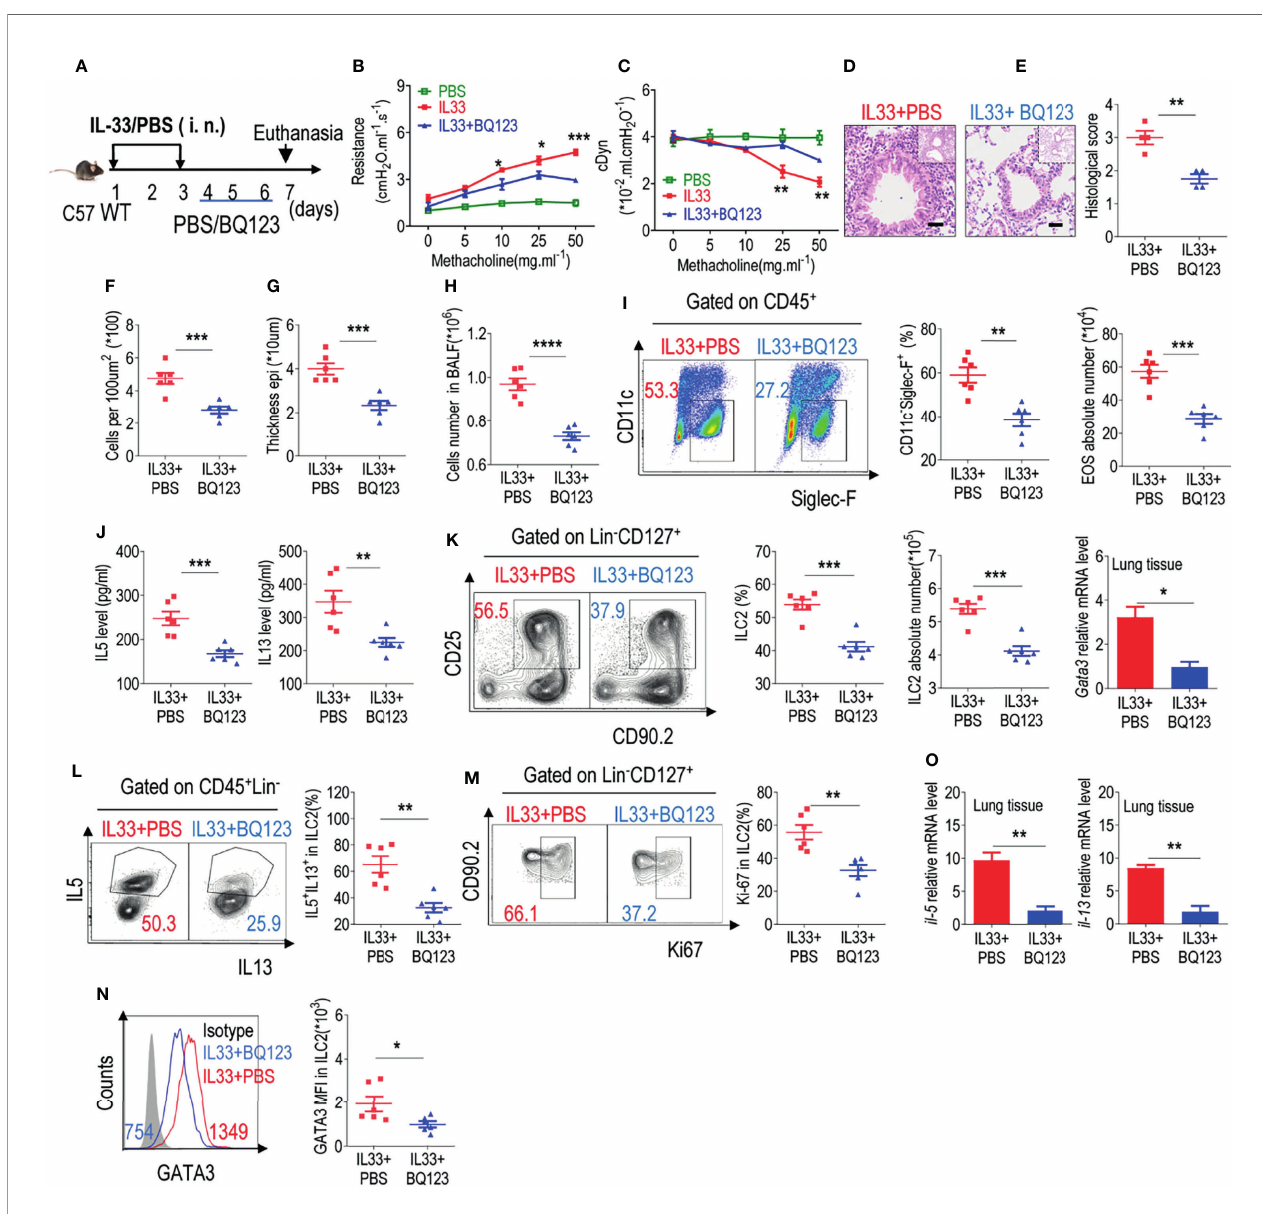
FIGURE 3 | BQ123 exerted a potential therapeutic effect on allergic in fl ammation. (A) Experimental scheme. Six-week-old C57BL/6 mice were challenged intranasally with rmIL-33 (0.5 µg) on days 1 – 3. Subsequently, the mice were treated intranasally with BQ123 or PBS control for three days and were sacri fi ced 24 h after the last injection on day 7. (B, C) Line graphs show lung resistance and dynamic compliance (cDyn) in response to increasing doses of methacholine. (D – G) Representative hematoxylin and eosin (H&E) staining of lung sections (D) and in fl ammation scores (E) , as well as the in fi ltrating cells (F) and airway epithelium thickness (G) were shown. Absolute number of BALF (H) , typical example of fl ow cytometry and statistical results, the absolute number of EOS in the BALF (I) , and (J) Levels of IL-5 and IL-13 in the BALF were shown. (K – N) Representative results of fl ow cytometry and statistical analysis of the frequencies of ILC2s and absolute counts (K) , IL-5 + IL-13 + ILC2s (L) , Ki67 + ILC2s (M) , and levels of GATA3 protein (N) in the lungs were indicated. (O) The mRNA expression levels of ILC2-related target genes in lung tissues, including Il5, Il13 , and Gata3 , were determined; b -actin level was used for normalization, and the lowest expression level in the IL33 + BQ123 group was arti fi cially set to 1 (n=3). Data are representative of two or three independent experiments (n = 6 for IL33 + PBS group; n = 6 for the IL33 + BQ123 group). *P < 0.05; **P < 0.01; ***P < 0.001; ****P < 0.0001. In all panels, individual results and mean ± standard error of the mean (SEM) are shown; statistical signi fi cance was determined using a two-tailed unpaired Student ’ s t-test (B, C, E – O)